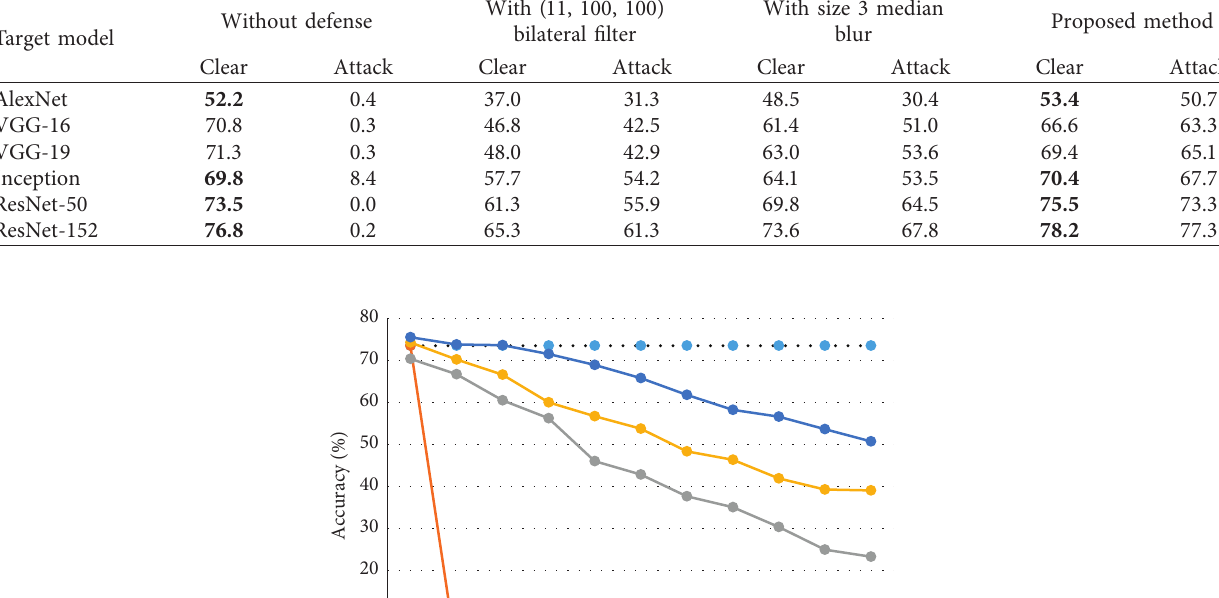
Table 1: Top-1 accuracy (%) under I-FGSM attack ( ϵ � 0.007, n � 100). Target model